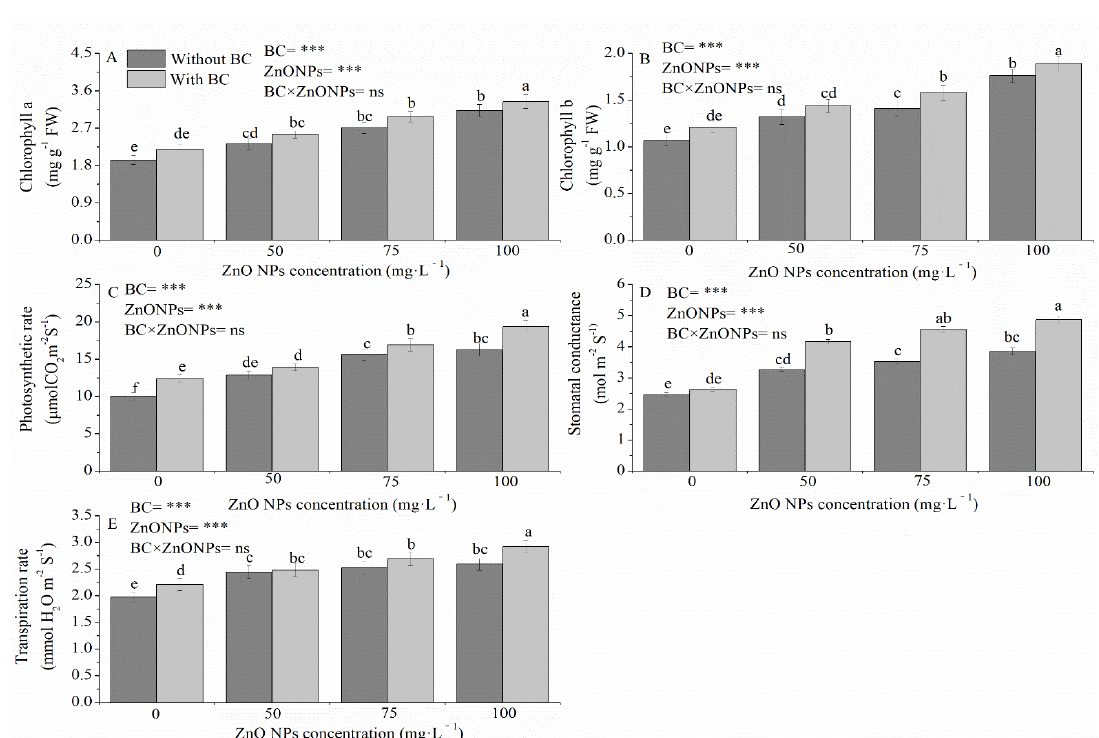
Figure 1. Effects of foliar-applied ZnO NPs alone and combined with bamboo biochar on ( A ) chlo- rophyll a, ( B ) chlorophyll b, ( C ) photosynthetic rate, ( D ) stomatal conductance, and ( E ) transpiration rate in maize plant under Cd stress. Bars show standard deviations of four replications. Different letters on the bars demonstrate the significant differences between treatments at p ≤ 0.05. In the figures: ns: non-significant; and *** significant at 0.001 levels.